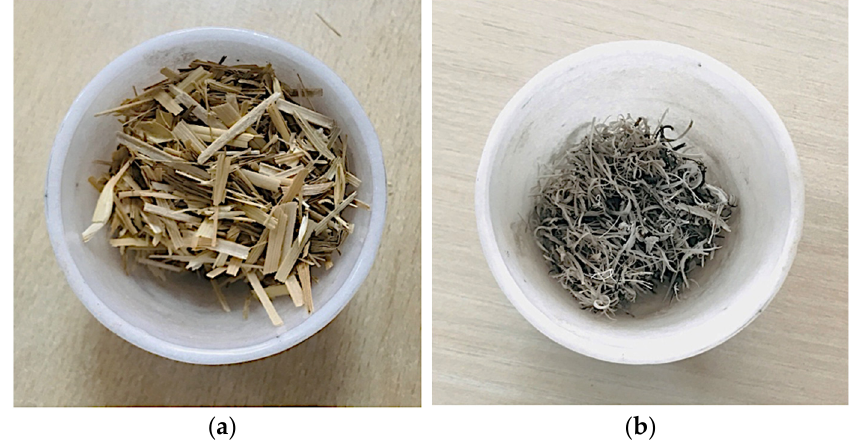
Figure 2. Wheat straw ( a ). Wheat straw ash (WSA) ( b ).